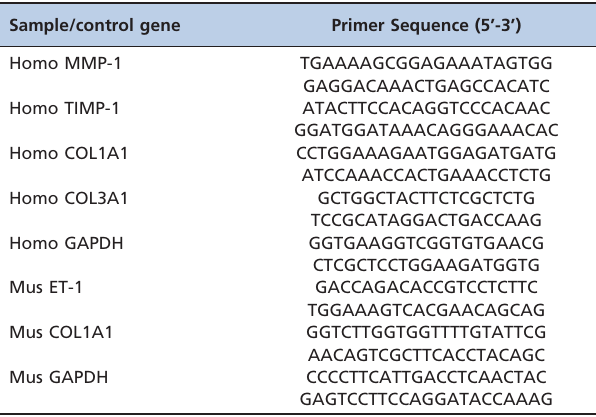
Table 1 - List of primers used for real-time